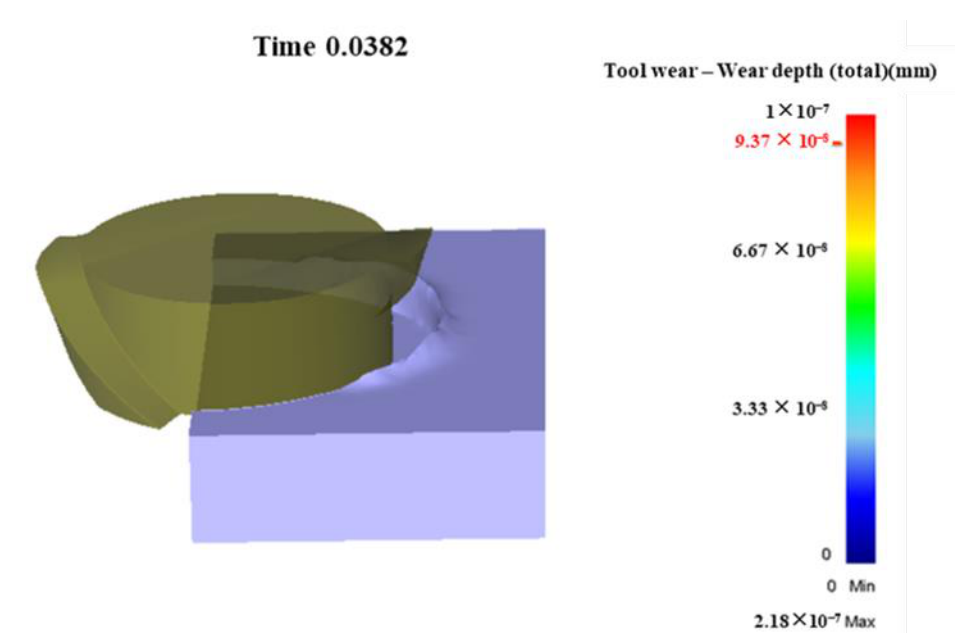
Figure 7. Tool wear depth based on simulation of micro-milling process.